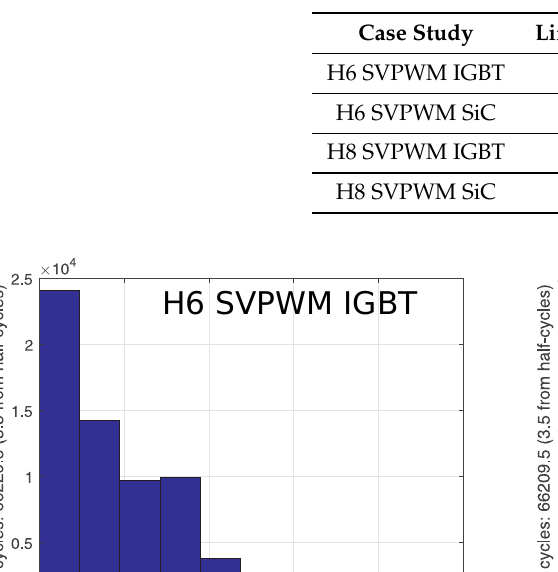
Table 7. Expected lifetime forecast through rainflow analysis.